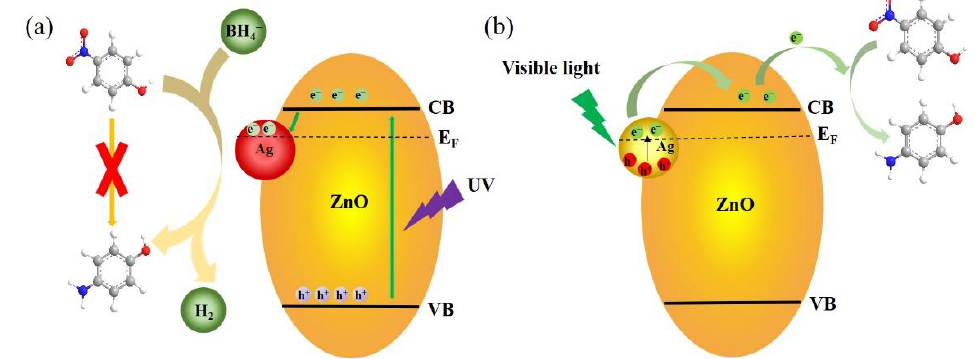
Figure 4. Schematic diagram of photocatalytic mechanism Ag/p-ZnO heterostructure under ( a ) UV and ( b ) visible